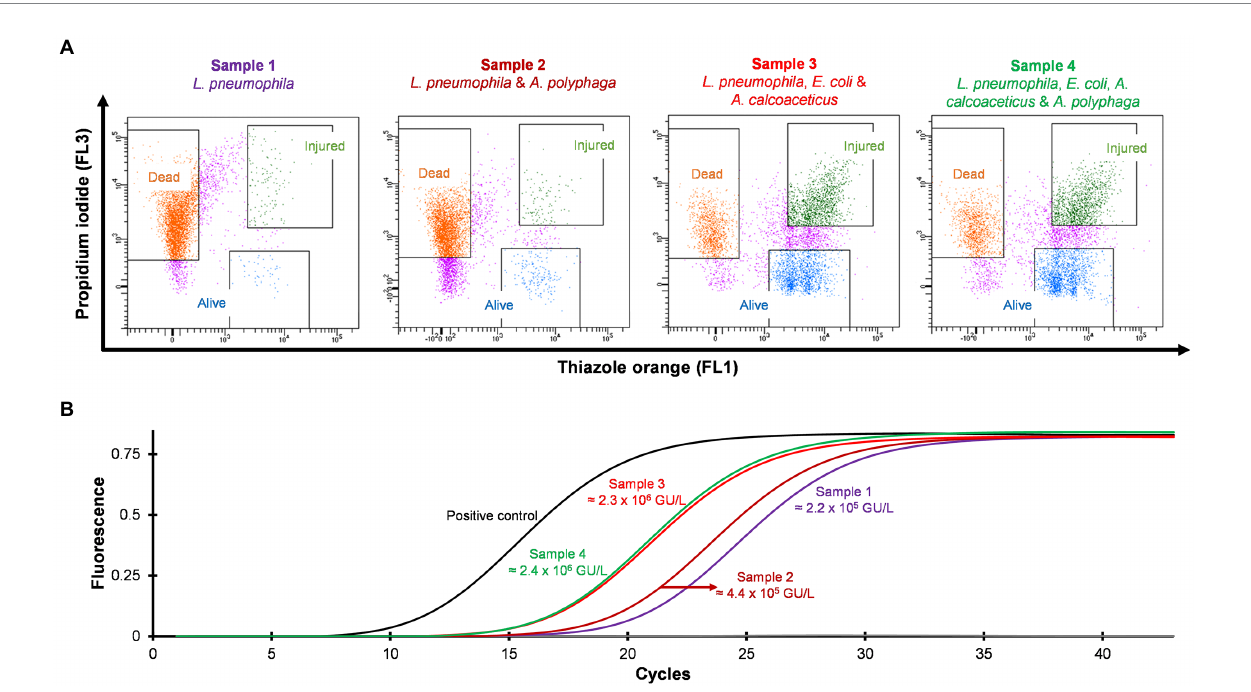
FIGURE 5 Detection and quantification of VBNC L. pneumophila from spiked water samples. All four spiked water samples were heated at 50 ° C for 15 min to generate VBNC Legionella . (A) Cytograms of four different water samples spiked with 4.5 × 10 6 CFU/L L. pneumophila . Samples 3 and 4 generated the highest amount of VBNC cells. (B) qPCR of VBNC (collected injured fraction) Legionella taken from the four